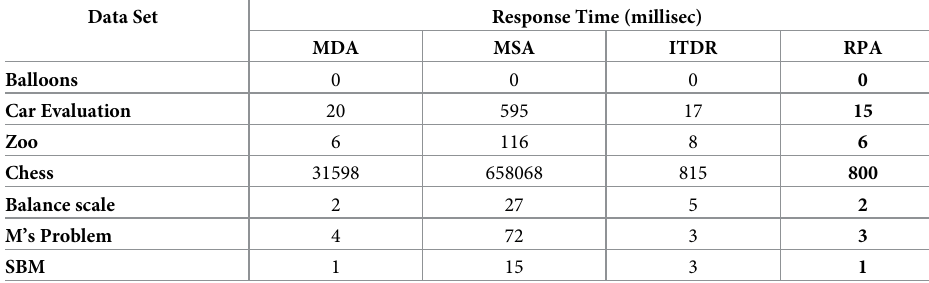
Table 11. Time complexity of all